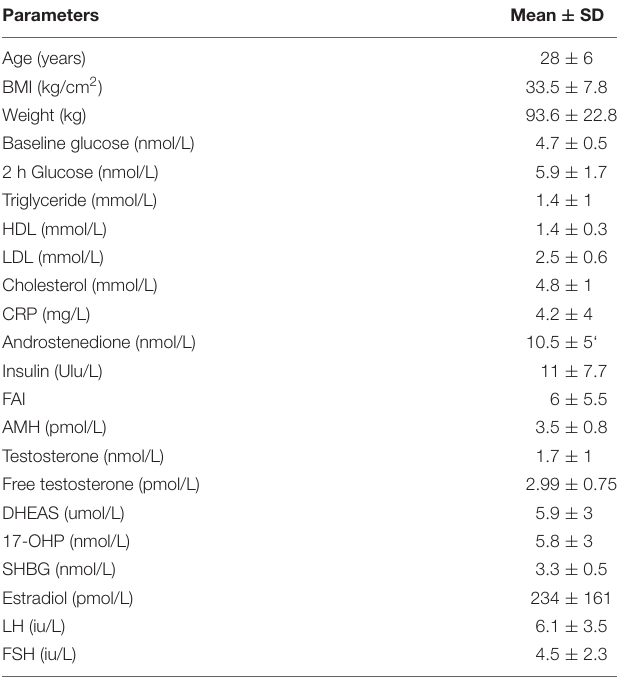
TABLE 1 | Baseline characteristics of the study population. Parameters